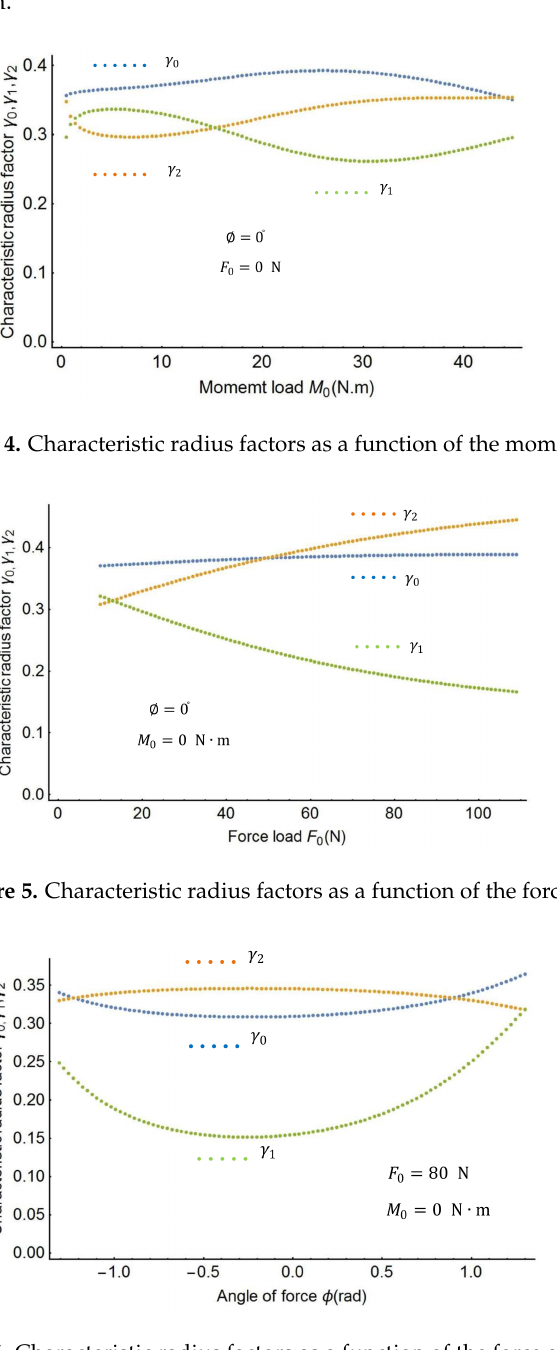
Figure 6. Characteristic radius factors as a function of the force